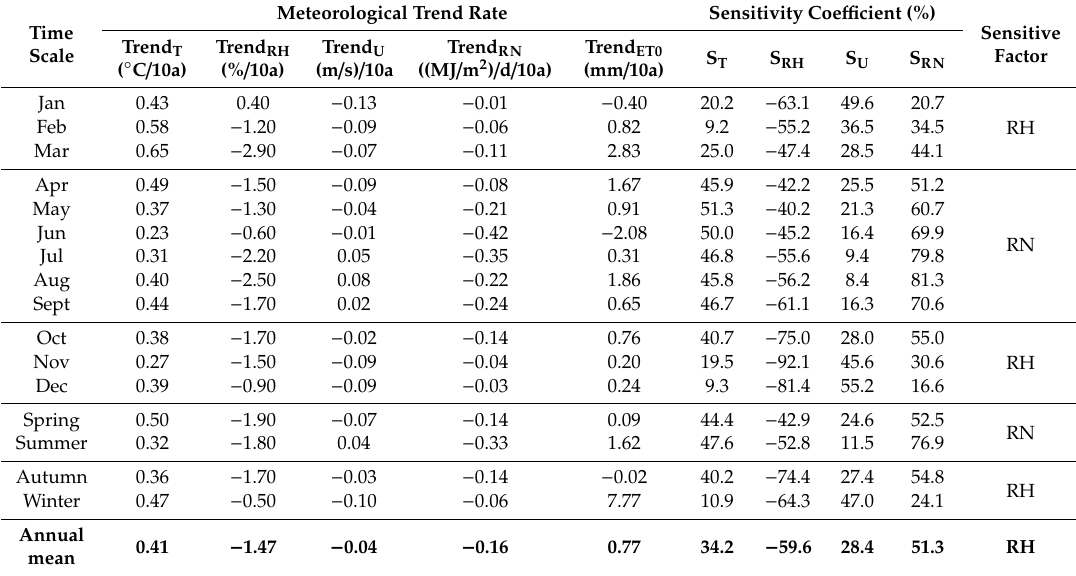
Figure 4. Variations in the annual average daily sensitivity coe ffi cients of the four meteorological factors. Table 1. Change rates and sensitivity coe ffi cients of the four meteorological factors on monthly and seasonal